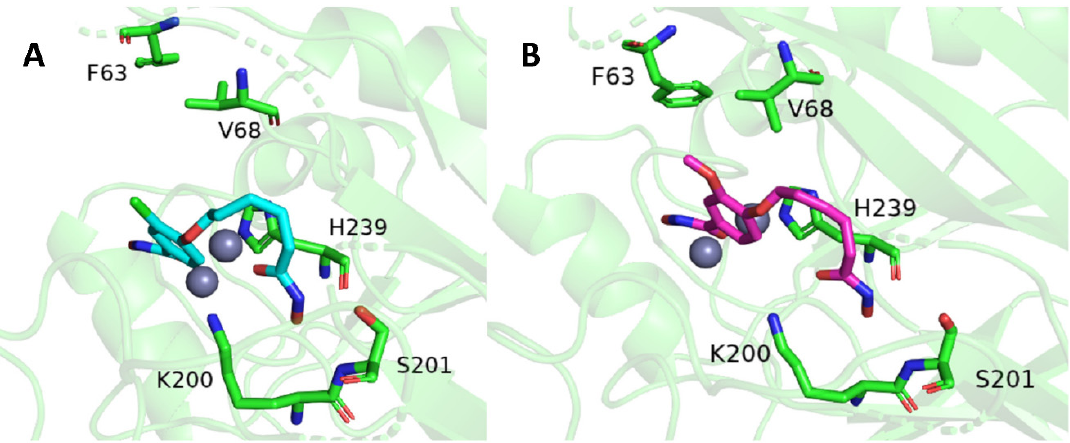
Figure 3. Average atomic coordinates of the root mean square fluctuation for both Compound 4 in cyan ( A ) and Compound 6 in purple ( B ). Some key amino acids were shown for both Compounds.